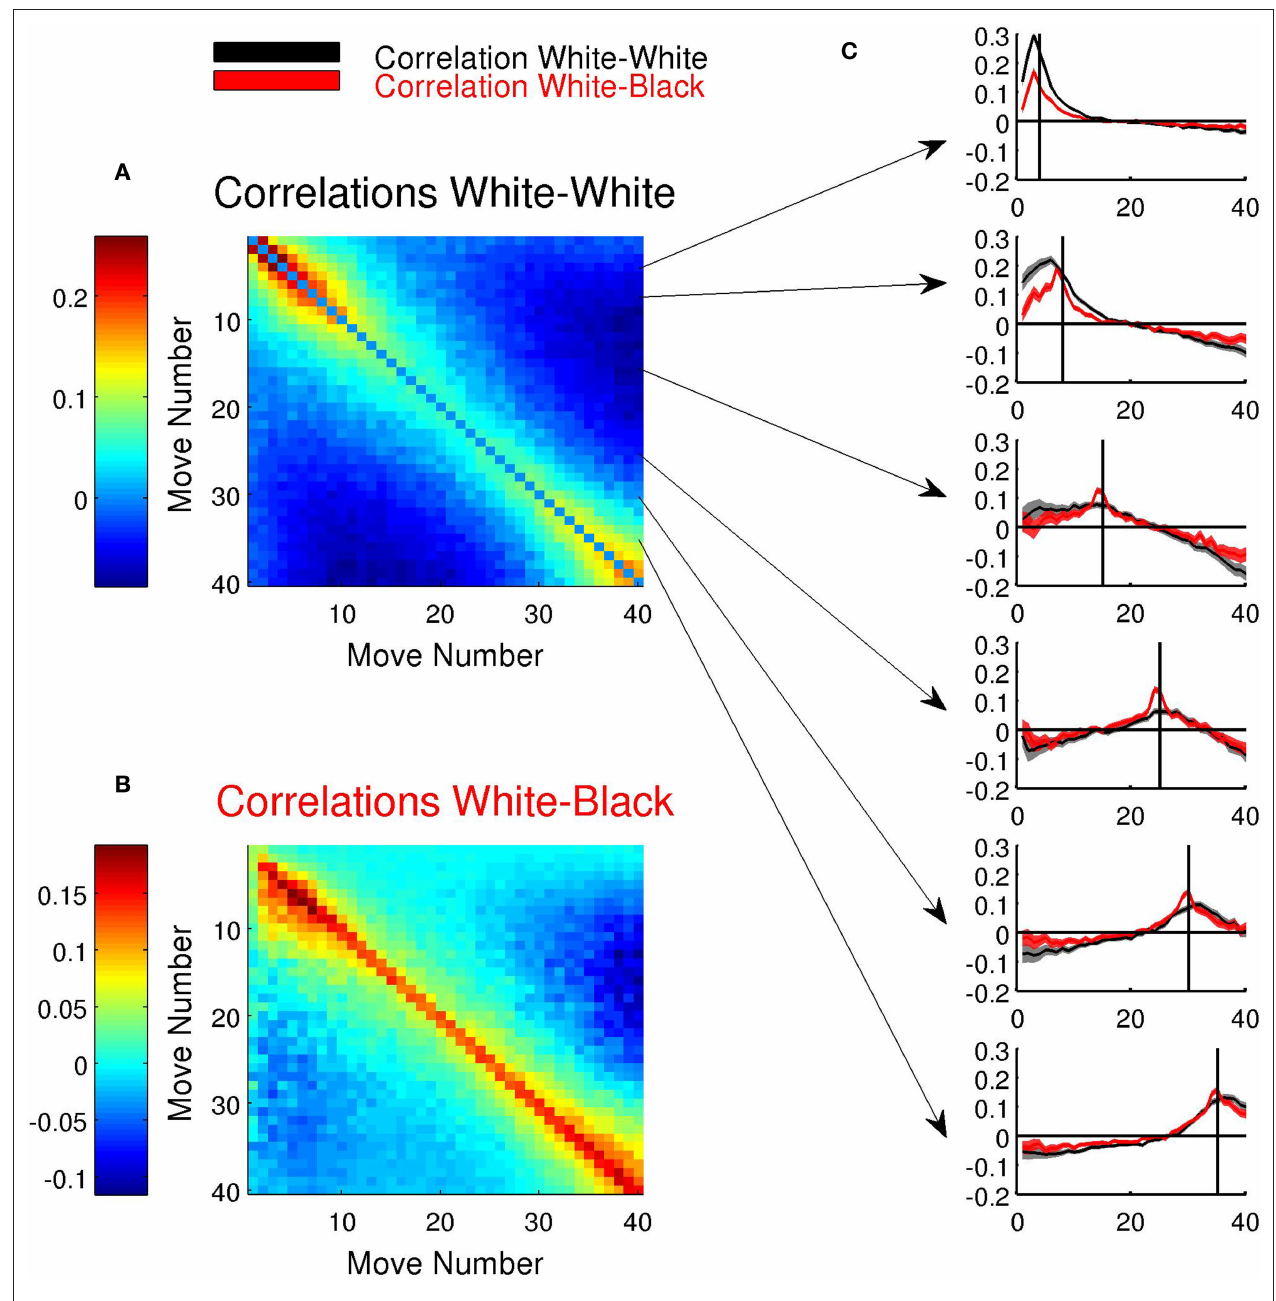
Figure 3 | Correlations in rT distributions: (A) Correlation matrix of move durations. The color of the position ( i , j ) of the image codes the correlation of white-move i , with white-move j . (B) Same as (A) , comparing the correlation of the duration of players playing white and black.